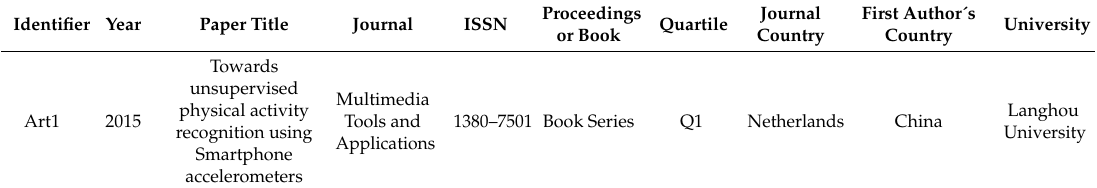
Table 6. General information of publication analyzed in a meta-analytical matrix.